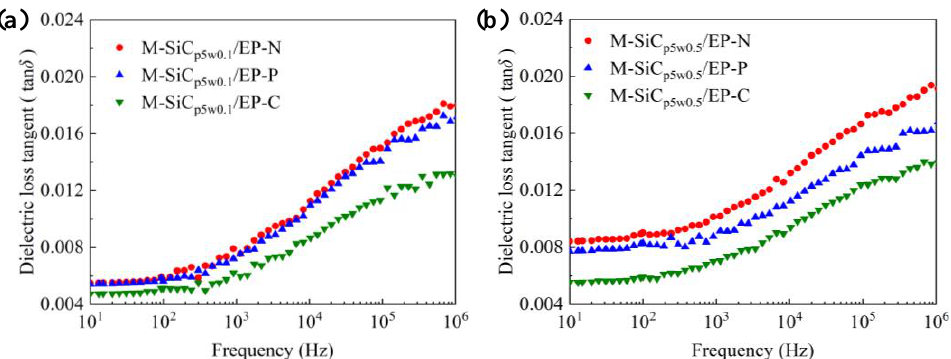
Figure 11. Dielectric loss spectra of M-SiC/EP composites under three action modes of magnetic field. ( a ) M-SiC p5w0.1 /EP; ( b ) M-SiC p5w0.5 /EP.